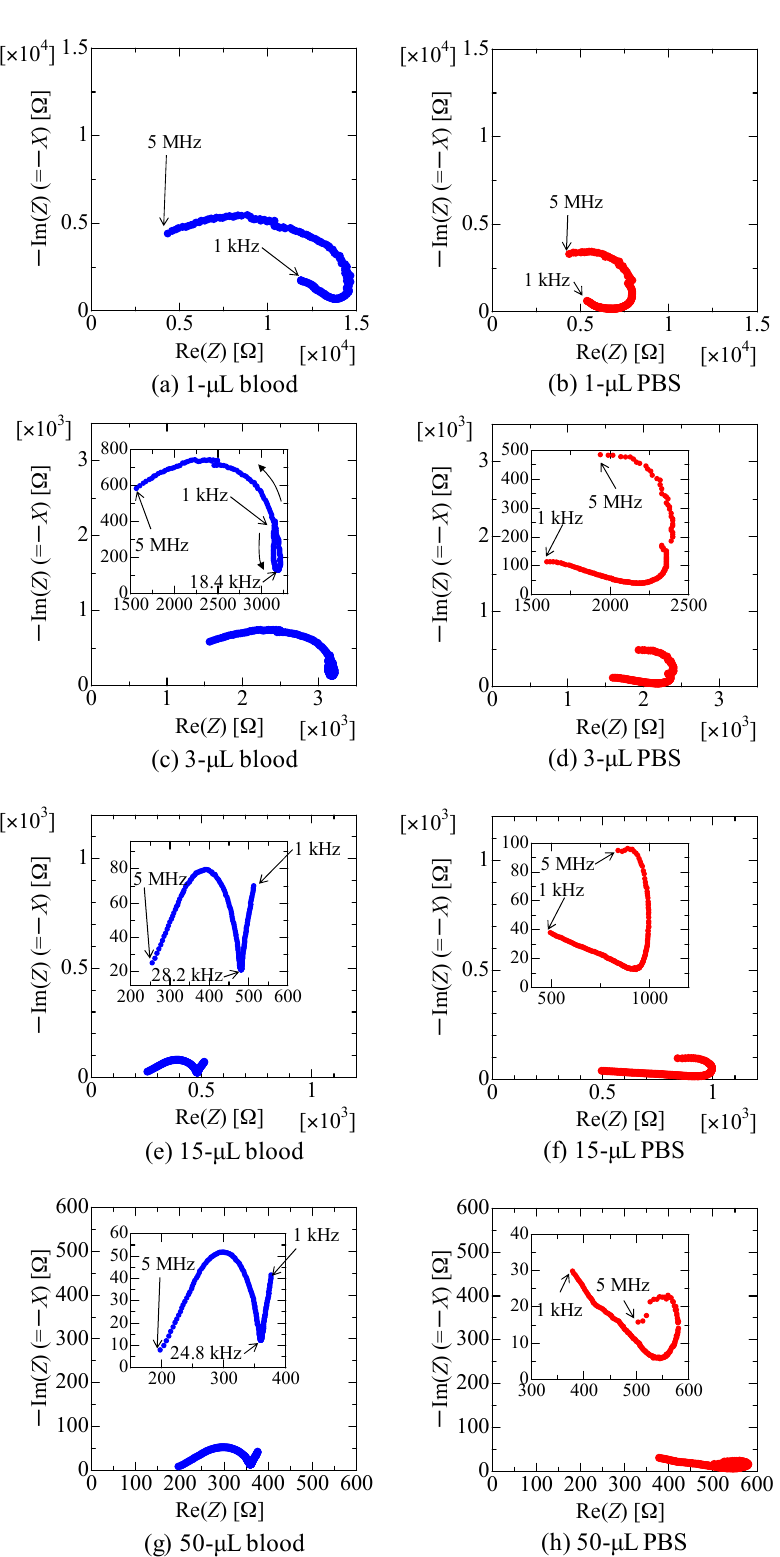
Figure 6. Nyquist plots of the sensors under representative conditions; after dropping 1 μ L of ( a ) blood or ( b ) PBS; 3 μ L of ( c ) blood or ( d ) PBS; 15 μ L of ( e ) blood or ( f ) PBS; and 50 μ L of ( g ) blood or ( h ) PBS. Insets are enlarged figures.